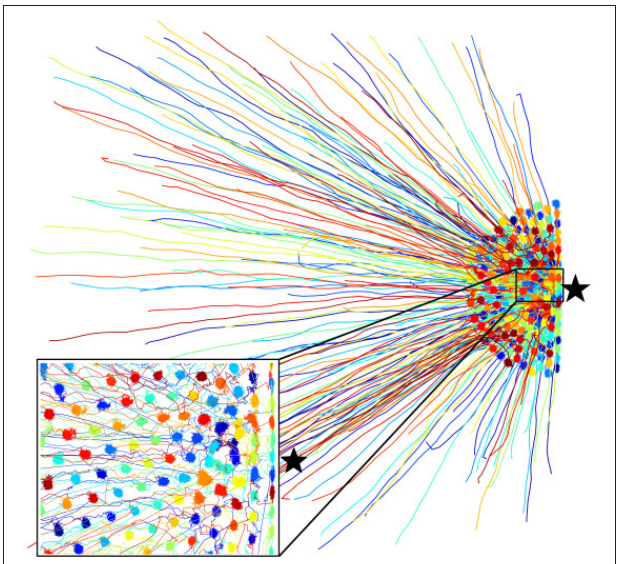
FIGURE 3 | Trajectories r i ( t ) for N 200 SPPs in a typical simulation run of the = asocial model for high-density human crowds. After a transient period (radial lines toward ⋆ ), the SPPs reach a stable state where they randomly oscillate about their average position (inset, dense squiggles). Each SPP is given a different color to more easily distinguish it from its